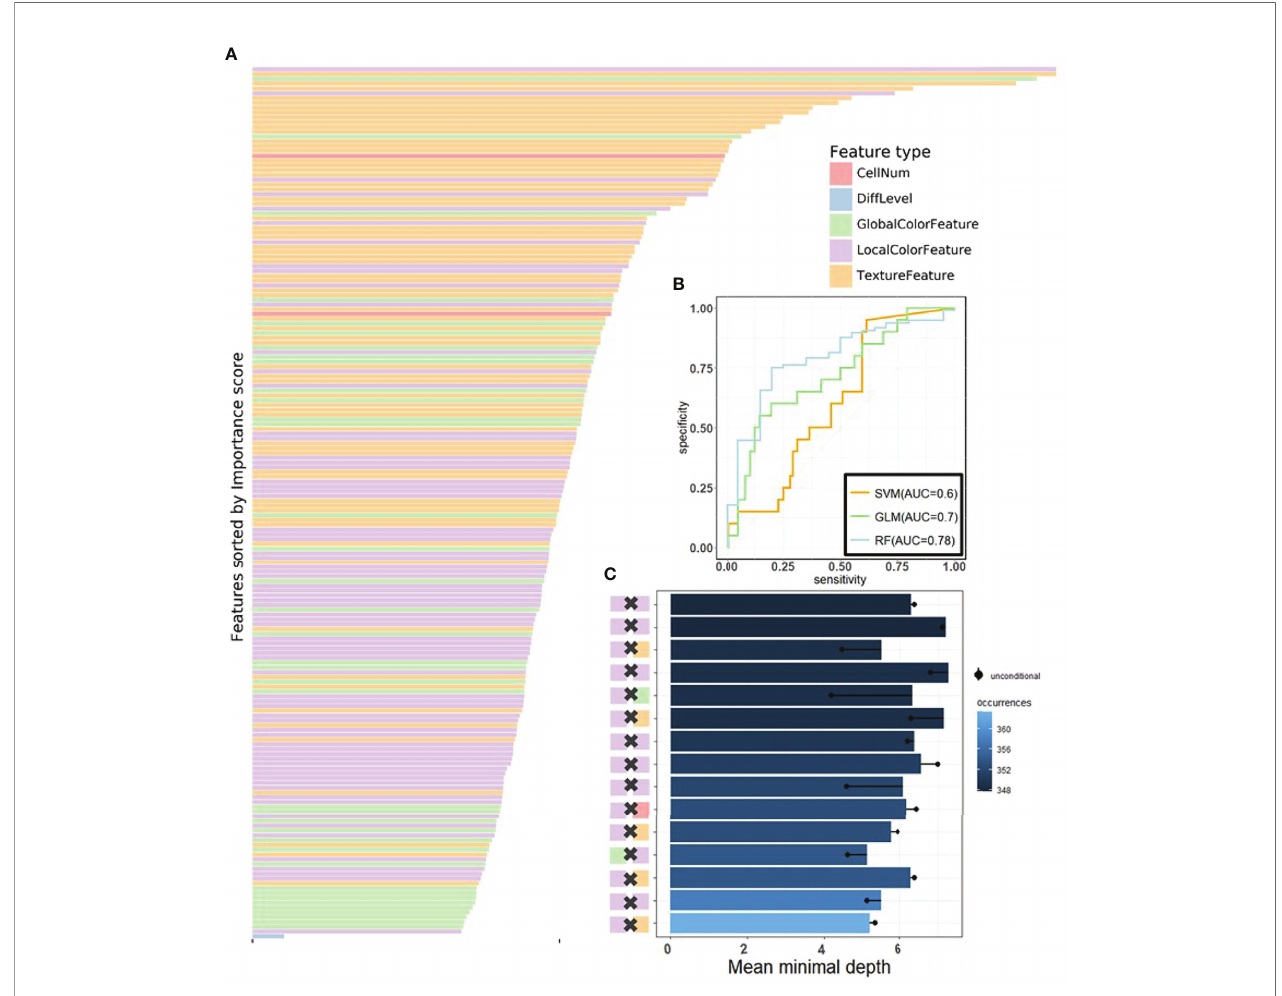
FIGURE 4 | The visualization of performance and interpretability of the RF in KR dataset. (A) The bar plot of permutation-based variable importance. Features are arranged from top to bottom in order of importance (the names of the features are provided in the order in Table S2 ). (B) The patient-level ROC curve for classifying MSI versus MSS with random forest. Three colors distinguish GLM, SVM, and RF. The 95% con fi dence intervals (CIs) computed by the bootstrap method are as follows: (0.53, 0.83) for GLM, (0.49, 0.72) for SVM, and (0.70, 0.82) for RF. (C) The bar plot of the mean of conditional minimal depth (the top 15 feature pairs of interaction are shown). A feature pair of interaction is listed as A × B, where A and B are one of feature type and their concrete names are listed in Table S3 . Feature pairs are arranged from the bottom to top in the order of the occurrences, which are represented by the color intensity of the bars. The bar ’ s length indicates the mean of conditional minimal depth and the distance from the dot to the y-axis measures the mean of minimal depth of (B) The length of the dot line implies the gap between them, measuring the effect of pairwise feature interaction. A large gap implies a strong interaction (see also Figures S1 – S3